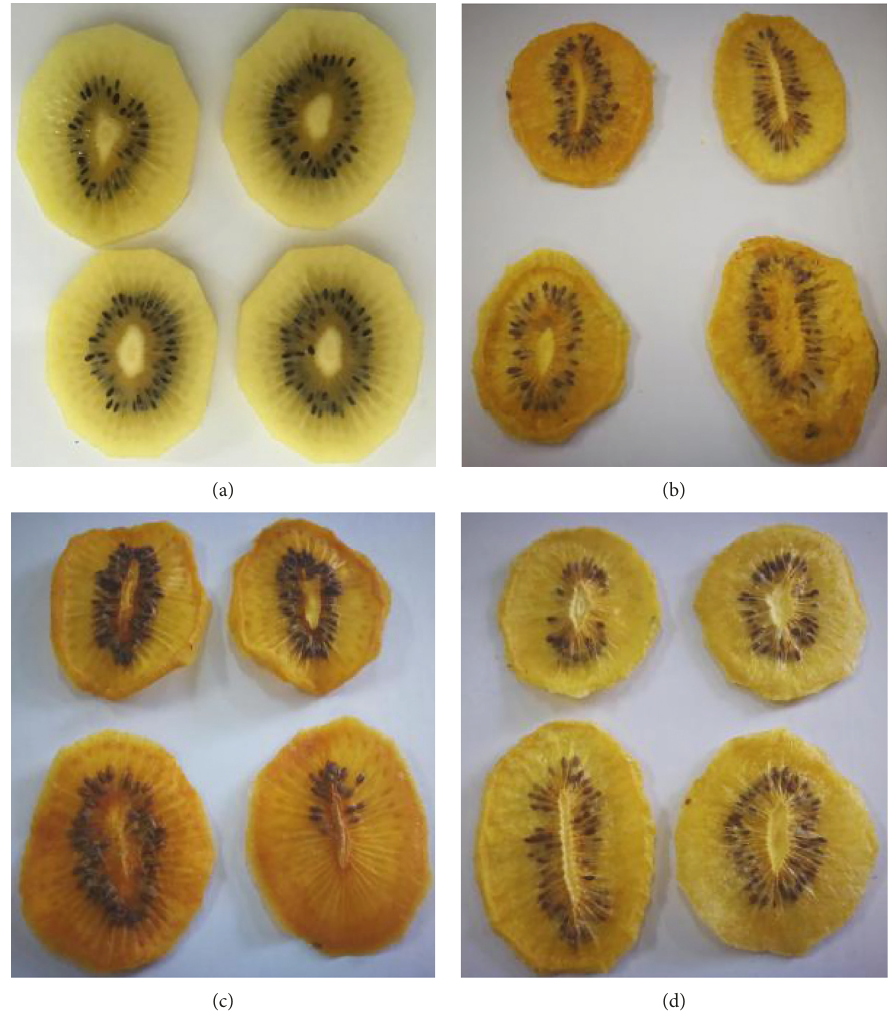
Figure 2: Images of a fresh kiwifruit sample (a) and kiwifruit samples dried by FVD (b), AD (c), and FVD-AD (d); FVD: freeze vacuum drying; AD: air drying; FVD-AD: combined drying consisting of vacuum freeze drying and air drying. Table 2: Drying time, hardness, moisture content, and water activity of kiwifruits samples dried by different drying methods. Drying method Drying time